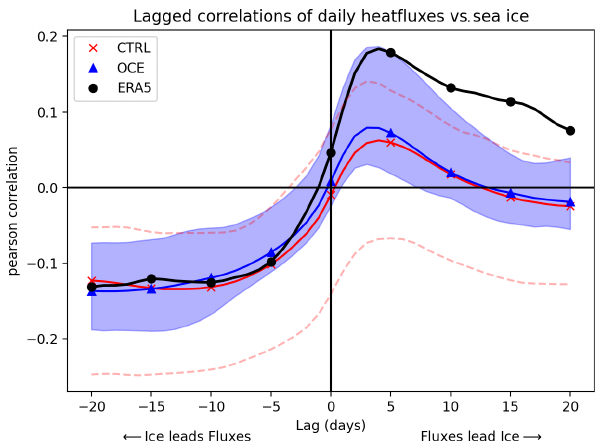
Figure 10. Lagged correlations of the daily BKS heat fluxes against daily BKS sea ice for ERA5 (black dots), CTRL (red crosses), and OCE (blue triangles). Negative lags correspond to the ice forcing heat fluxes, and vice versa for positive lags. Note that positive heat flux values correspond to an upwards flux. Correlations are com- puted using all days in November through February, 1980–2015. Blue shading indicates the ensemble spread of OCE; the CTRL spread is indicated by stippled red lines. Note that only every fifth point has been marked by a symbol for visual